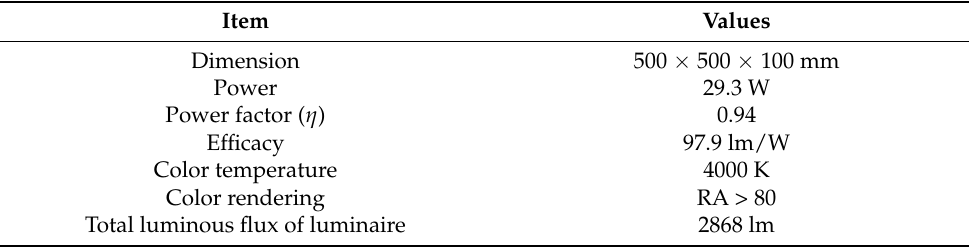
Figure 4. Details of the luminaire. ( A ) is the outlook, and ( B ) is the polar intensity diagram of the luminaire. Table 4. Details of the